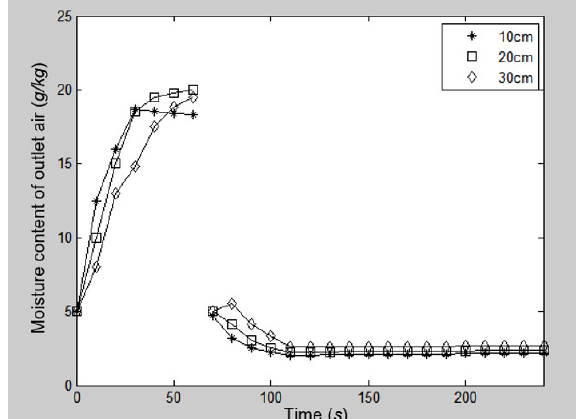
Figure 9. Change in air moisture content with time at the outlet of runner with different thicknesses.